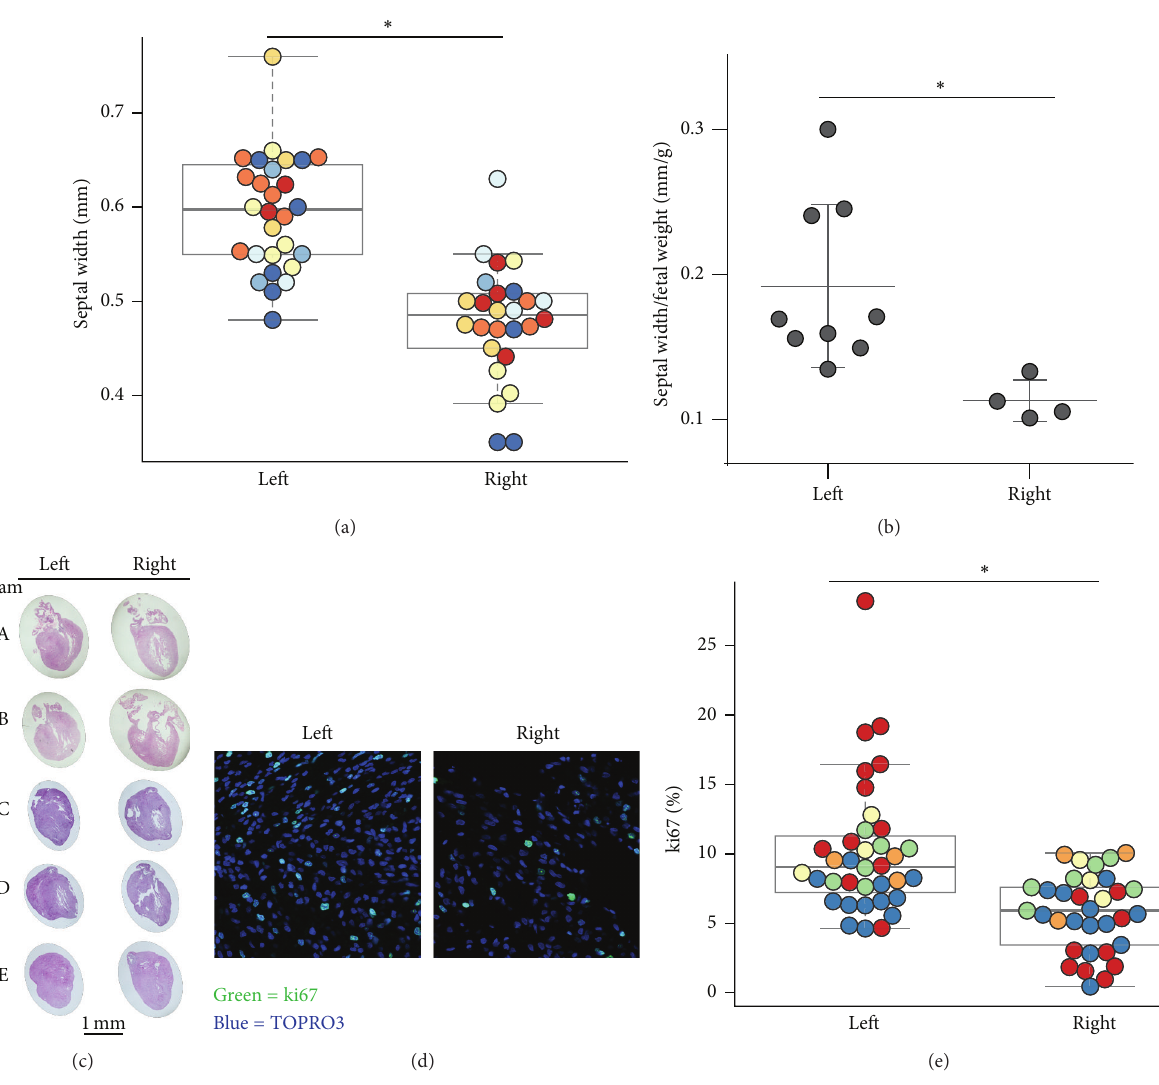
Figure2:Cardiacseptalwidthandmyocardialproliferation. (a)Fetalcardiacseptalwidth,asmeasuredbyechocardiograph,amongleft-sided (i.e., hyperglycemia infused) and right-sided (control) fetuses. Differing colors indicate different dams. ∗ 𝑃 < 0.0005 by resampling, 𝑁 = 7 dams, 𝑁 = 26, 28 fetuses per side. (b) The ratio of cardiac septal width to fetal weight. ∗ 𝑃 < 0.05 by 𝑡 -test, 𝑁 = 4, 9 fetuses per side, 2 dams. (c) Hematoxylin and eosin stained fetal hearts from the left (hyperglycemia) and right (control) uterine horns. (d) Myocardial proliferation as evidenced by immunofluorescence detection of ki67 (green) and DAPI (blue). Representative images from the interventricular septal region are shown. (e) The percentage of ki67 positivity among nuclei in the fetal myocardium. ∗ 𝑃 < 0.0005 by resampling, 𝑁 = 5 dams, > 500 nuclei from 3 myocardial regions (left, right, septal ventriculum) analyzed per fetus. 𝑁 = 33, 36 fetuses per